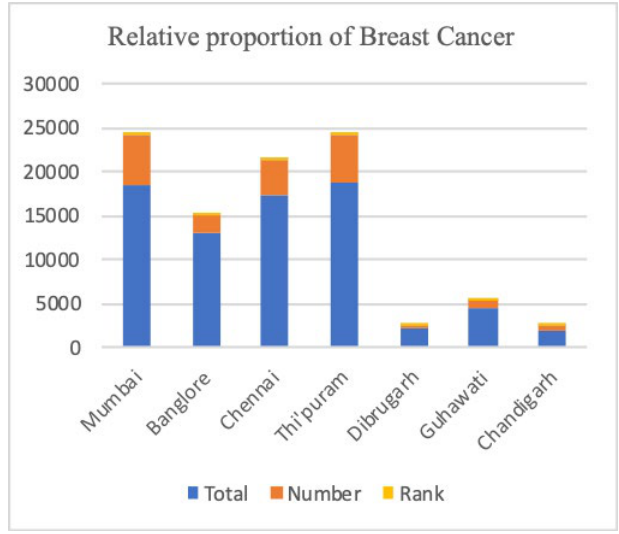
Figure 1. Relative proportion of breast